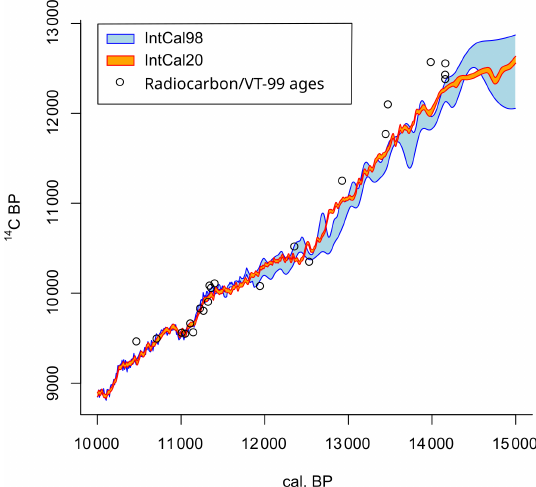
Figure A3. Radiocarbon ages vs. Intcal98- and Intcal20-calibrated ages between 10000 and 15000calBP. Black circles show radiocarbon ages from Holzmaar vs. VT-99 age (reworked samples excluded). An underestimation of these ages occurs after 12500calBP, where VT-99 seems to be too young.